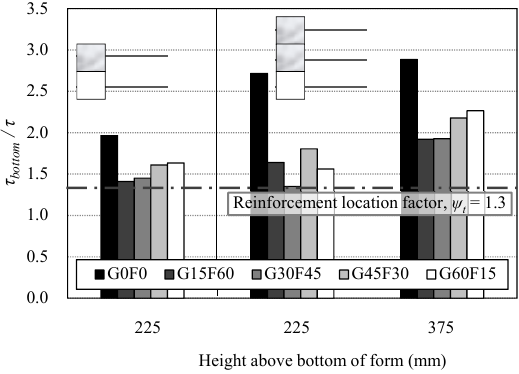
Figure 11. Casting position effect in terms of the location (height) of the rebar. Table 8. Bond strengths of H-type specimens.